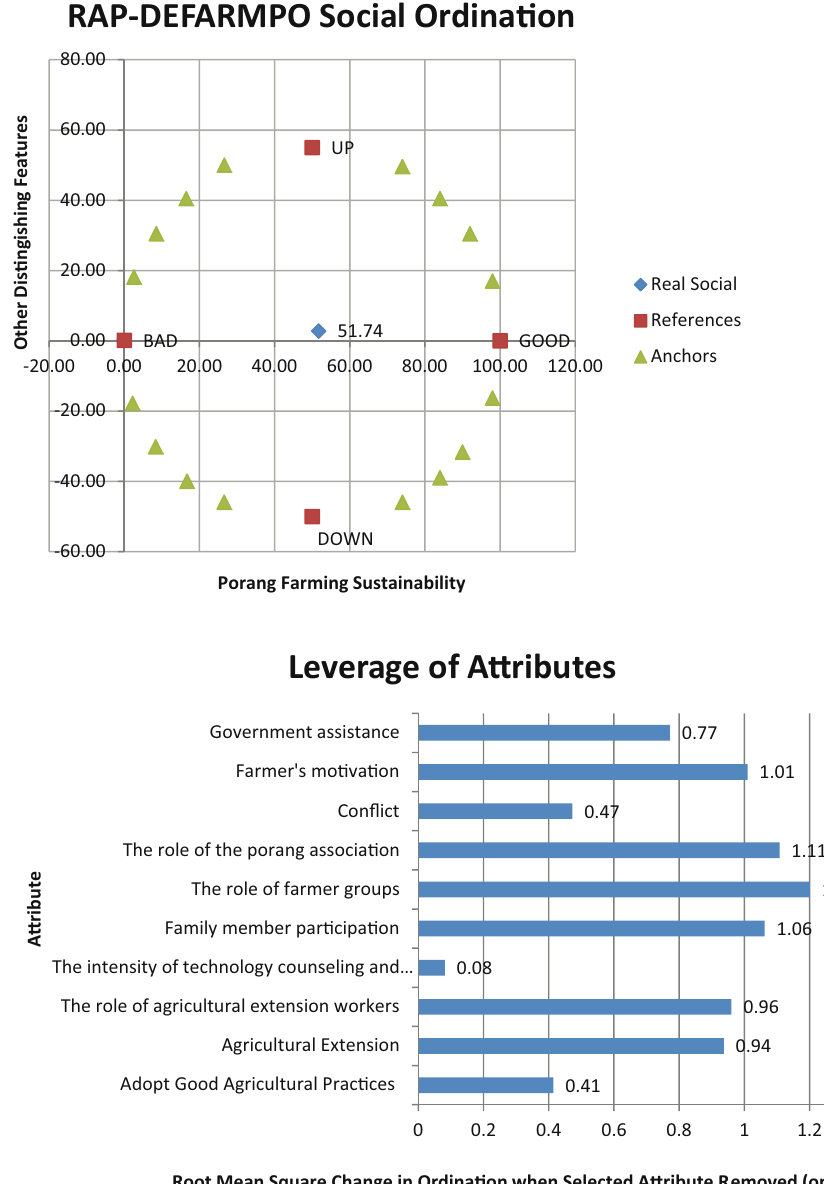
Figure 5: Social